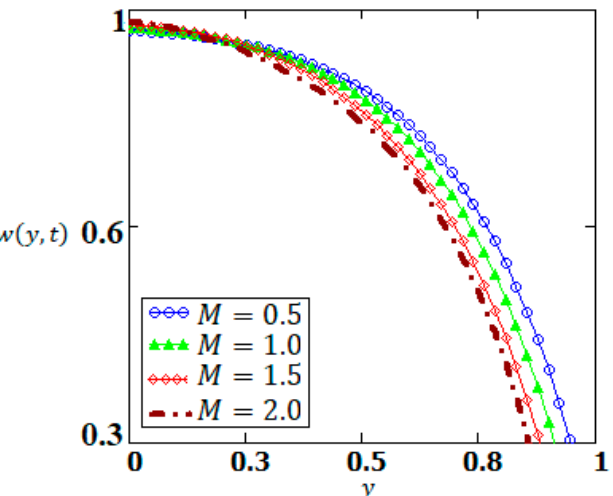
Figure 3. Effective role of mass concentration depicted from Equation (16) for S c .